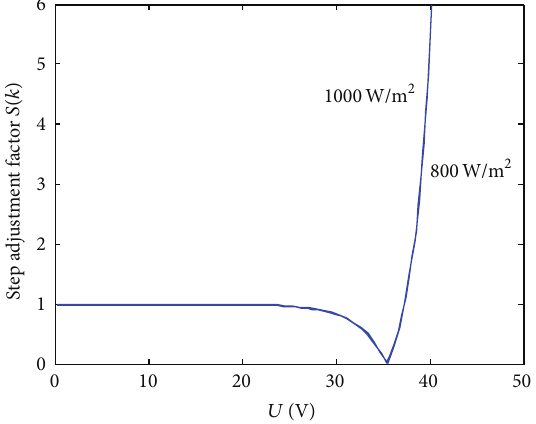
Figure 10: Relation curve of 𝑆(𝑘) against voltage 𝑈